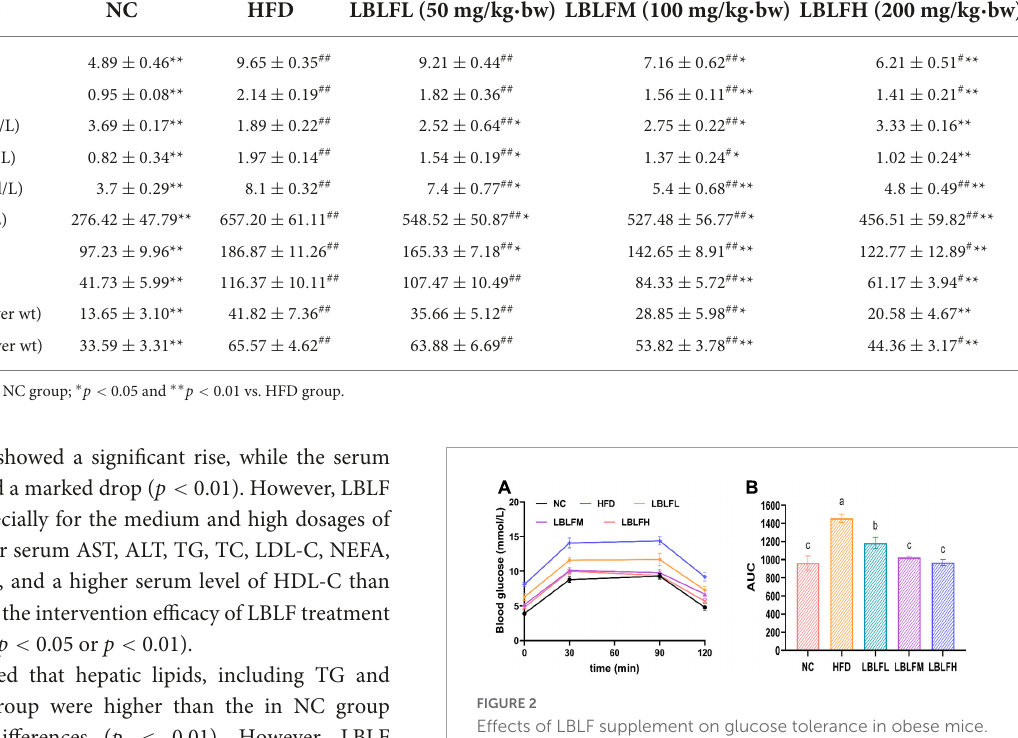
TABLE 2 Serum biochemical markers and hepatic lipids levels after 12 weeks. Sample Parameters